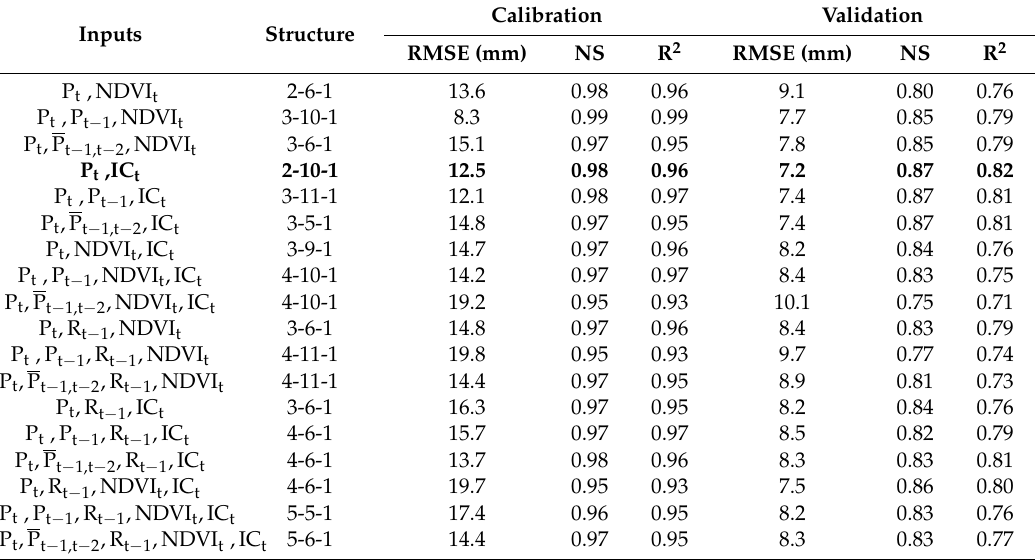
Table 5. Results of monthly time series modelling by ANN with different inputs during calibration and validation in the Haughton River